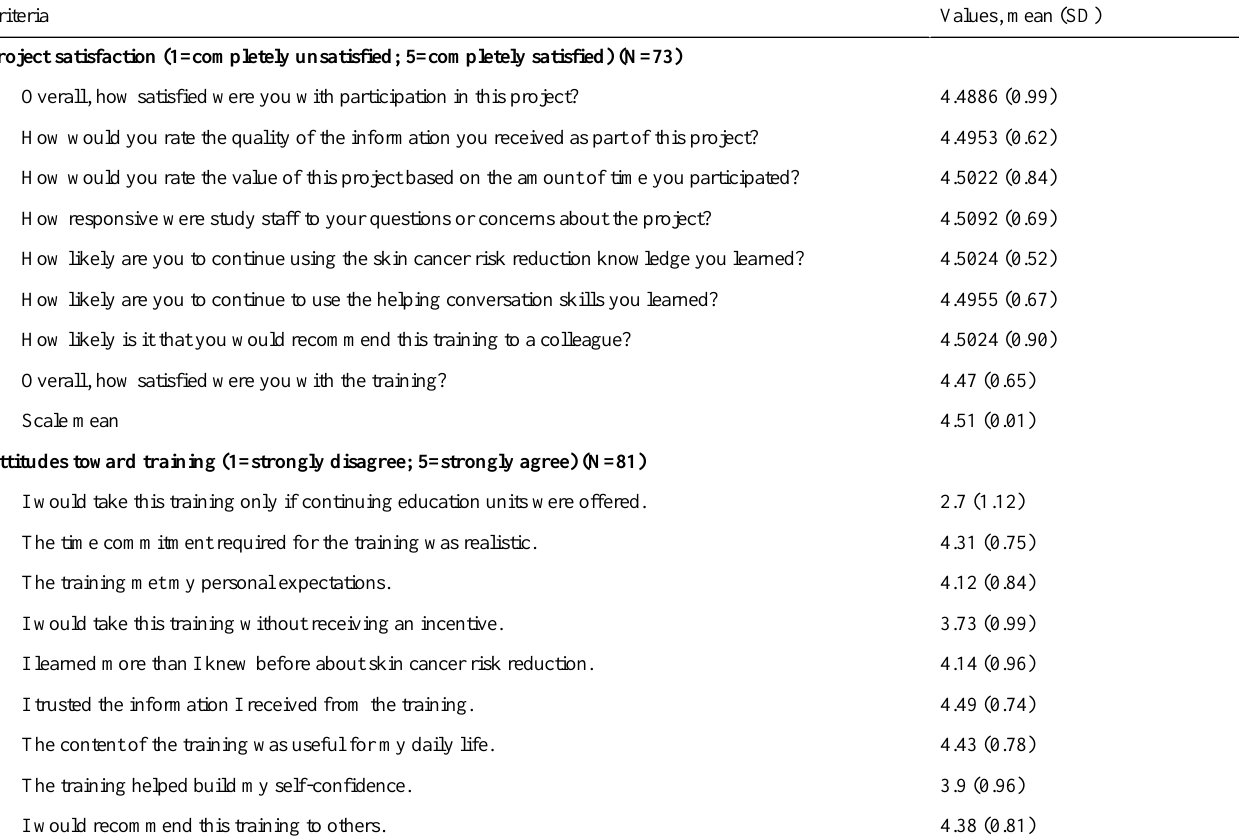
Table 2. Project satisfaction and attitudes toward training (N=73).